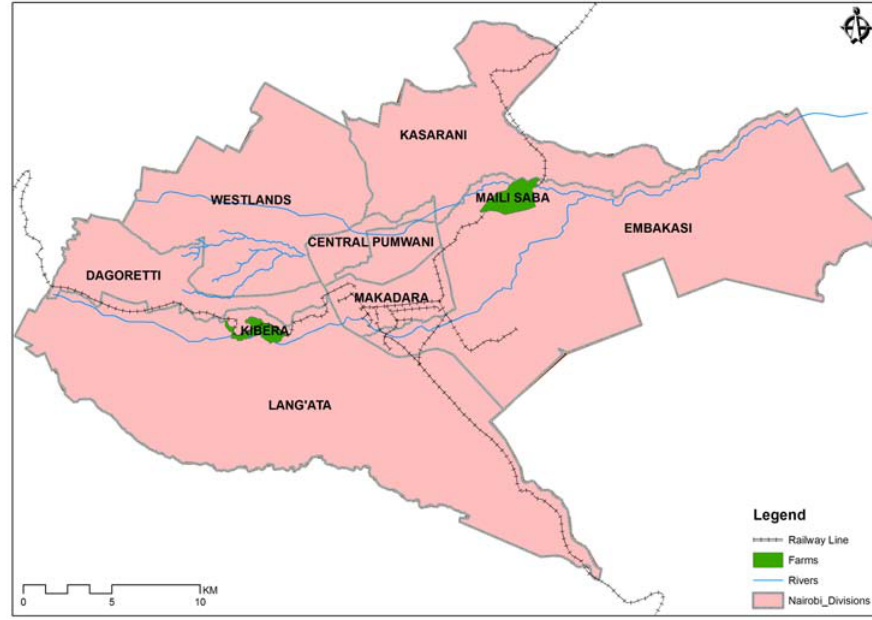
Map by Dennis Mwaniki.